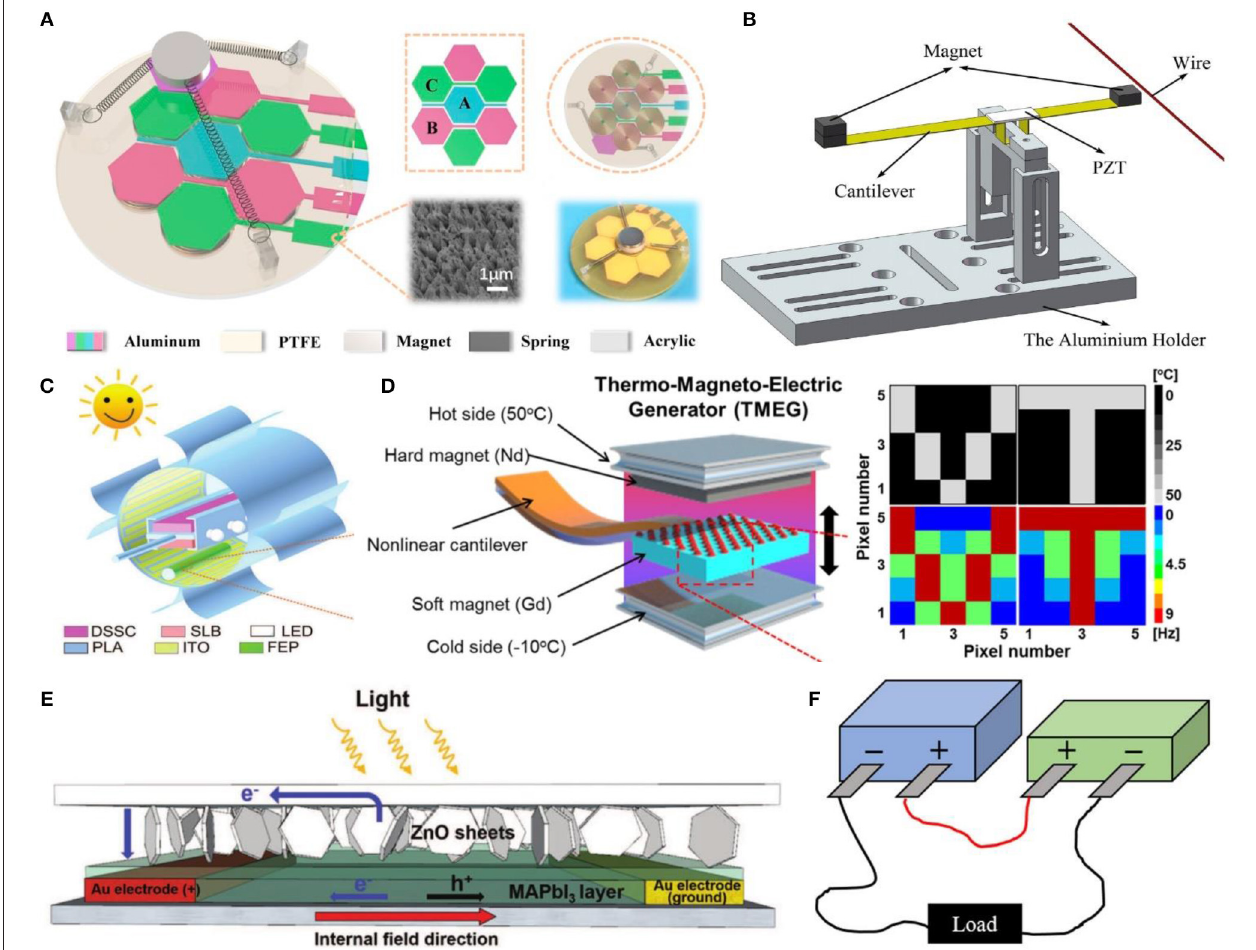
FIGURE 1 | (A) Schematic of a honeycomb-like, three-electrode and triboelectric-electromagnetic hybrid energy harvester for ocean waves. Reproduced with permission (Feng et al., 2018). Copyright 2018, Elsevier. (B) Schematic of a hybrid harvester for vibrational and magnetic energy. Reproduced under the terms of